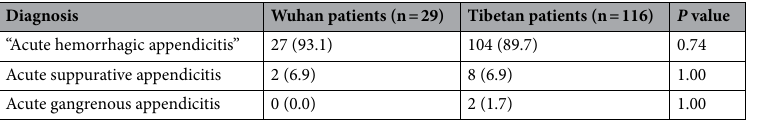
Table 3. The pathological diagnosis for Tibetan clustered patients and Wuhan clustered patients. Categorical variables were compared by the χ 2 test or Fisher’s exact test was used when the data were limited. A 2-sided α of less than .05 was considered statistically significant.